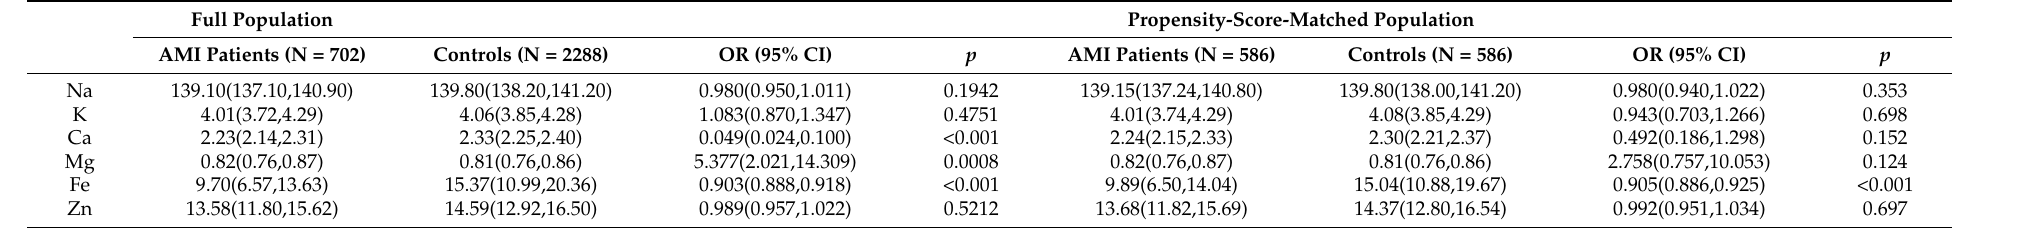
Table 4. Association between the levels of metals and AMI—control risk in the multivariable logistic regression model. Full Population